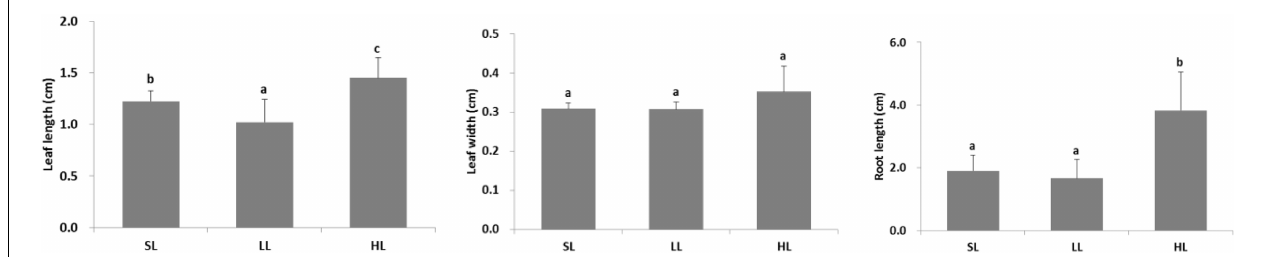
FIGURE 3 | Response of seagrass morphology to light treatments. Saturating light: SL, 200 µ mol photons/m 2 /s; low light: LL, 20 µ mol photons/m 2 /s; high light: HL, 600 µ mol photons/m 2 /s. SL and HL were in the optimal light range between the minimum saturating light and the minimum inhibiting light. Different letters on the bars indicate mean values for a particular light condition that significantly differed at ( p < 0.05) (Mean ± SD, n = 15) analyzed by one-way